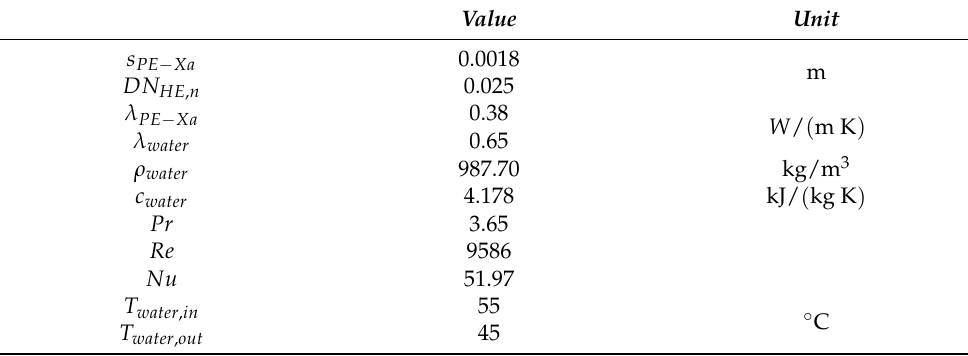
Table 6. HE structural and thermal